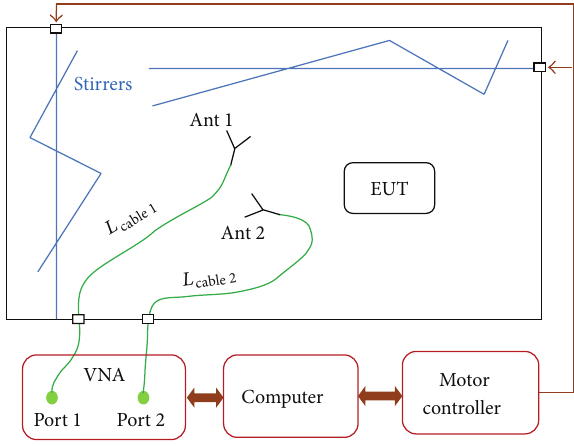
Figure 1: The RE measurement system in the IEC standard.